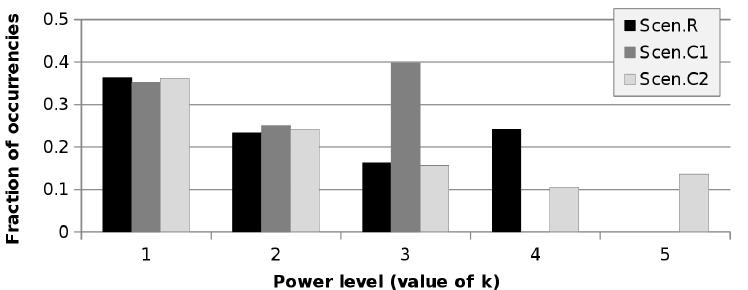
Figure 5. Occurrences of the power levels as a function of the test scenario for the case D =